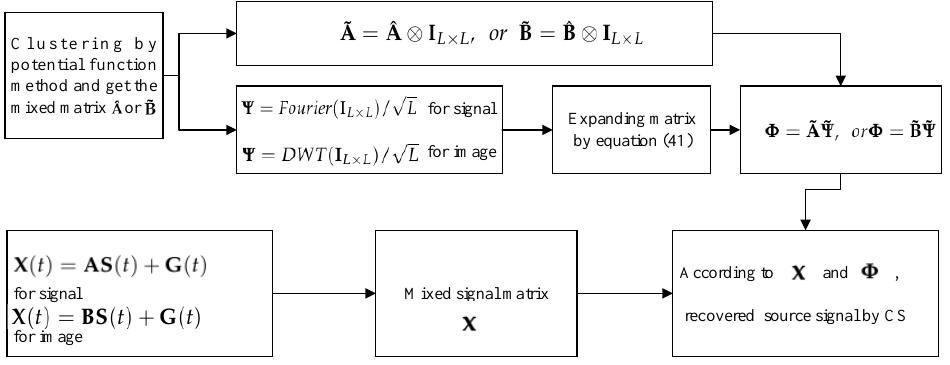
Figure 14. Flowchart of UBSS by